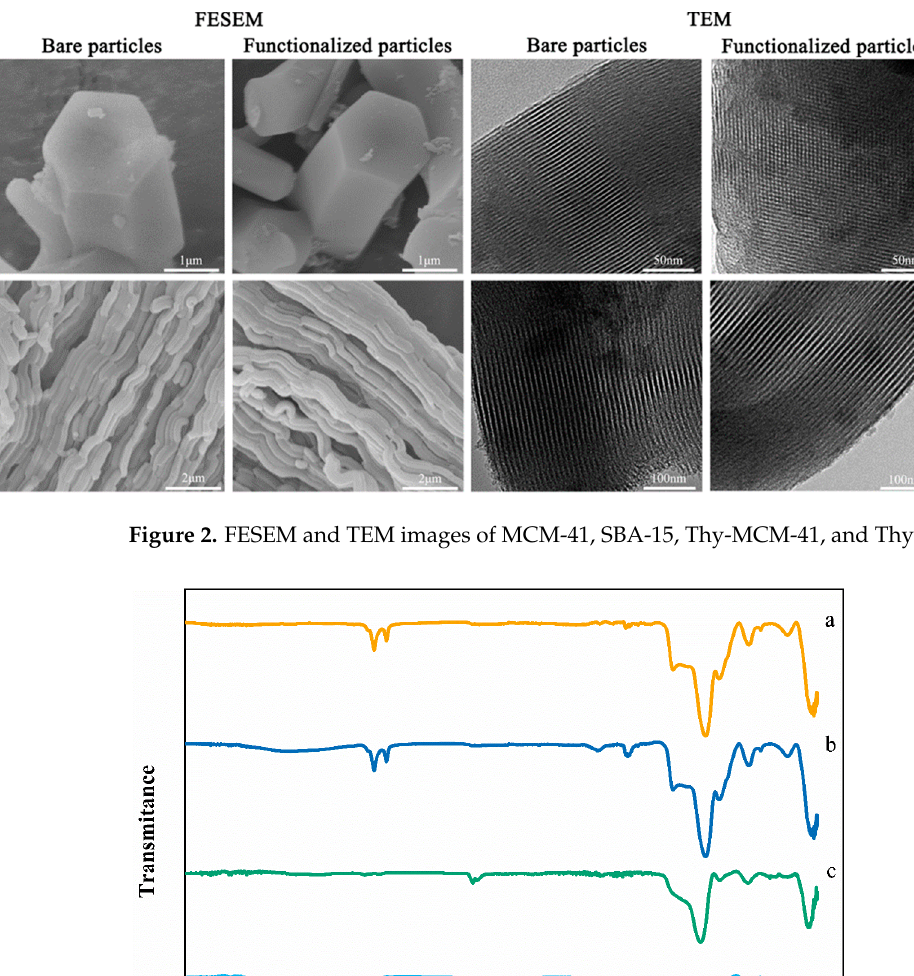
Figure 2. FESEM and TEM images of MCM-41, SBA-15, Thy-MCM-41, and Thy-SBA-15.